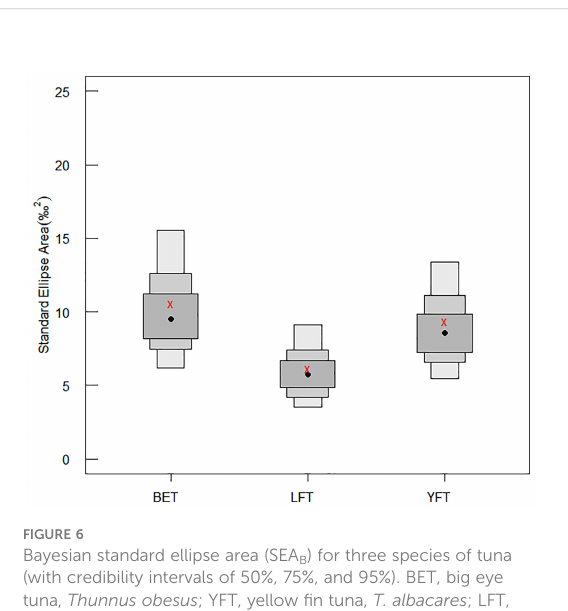
FIGURE 6 Bayesian standard ellipse area (SEA B ) for three species of tuna (with credibility intervals of 50%, 75%, and 95%). BET, big eye tuna, Thunnus obesus ; YFT, yellow fi n tuna, T. albacares ; LFT, albacore tuna, T. alalunga